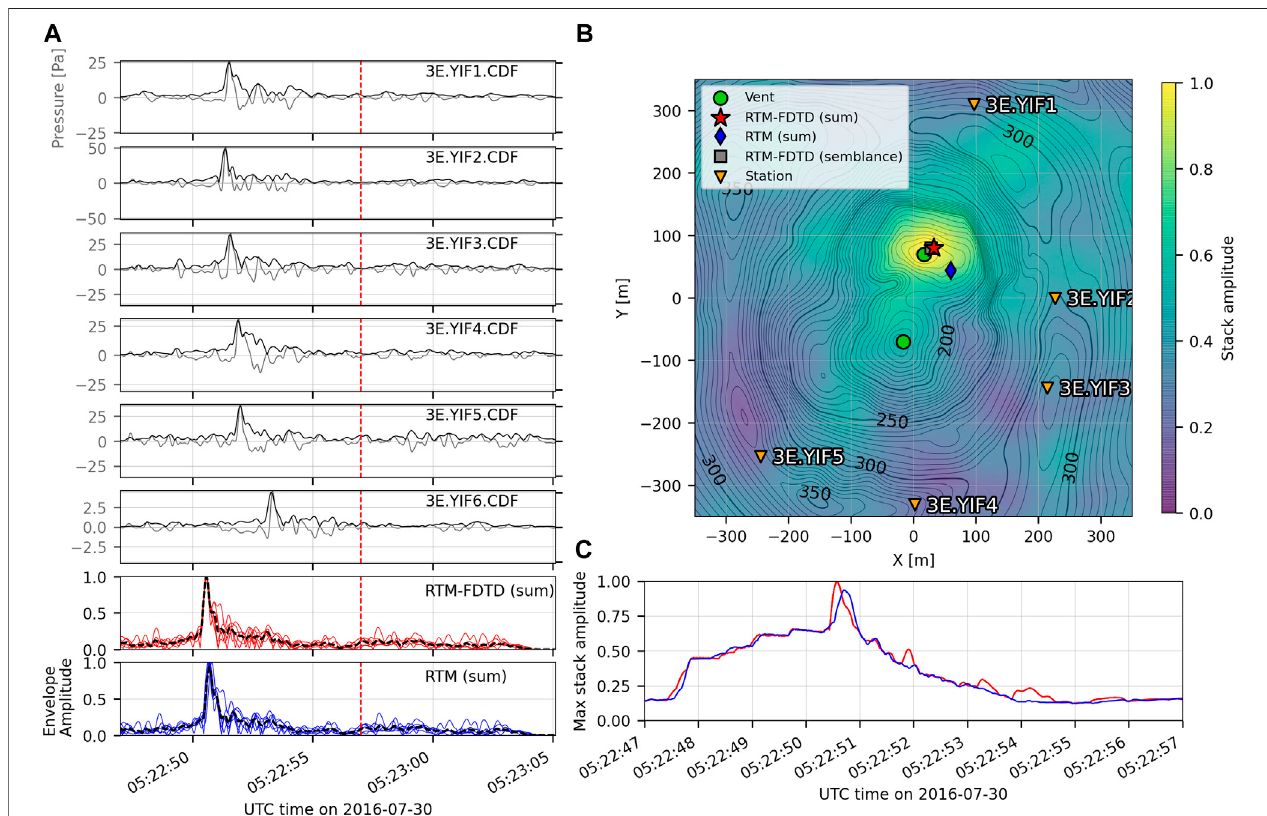
FIGURE 4 | Yasur Vent C explosion waveforms and location comparison. Figure layout is the same as Figure 3 . Both RTM-FDTD implementations locate the source to < 21 m of the assumed vent location, while RTM (sum) locates the source 59 m away.